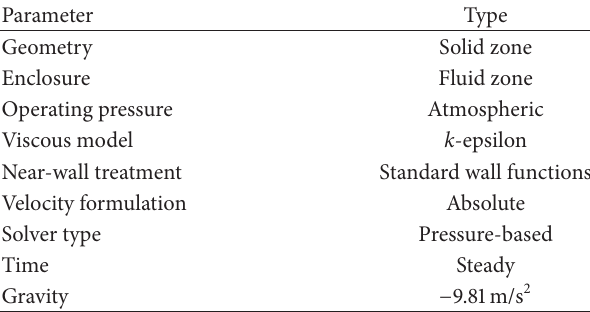
Table 1: Boundary